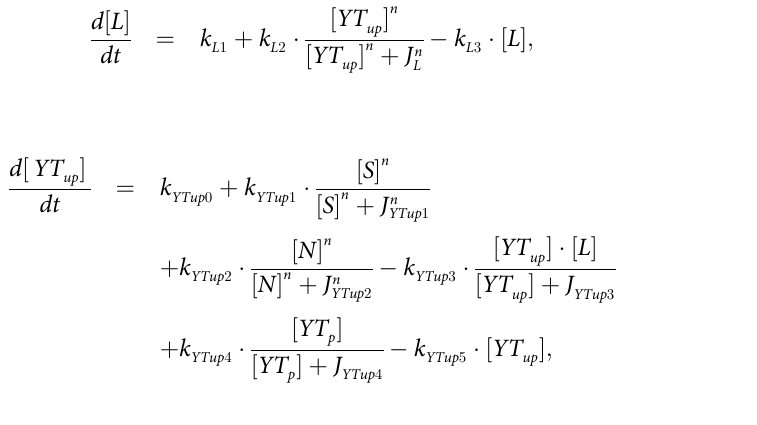
network in Fig 1. The Hippo signaling pathway regulates YAP/TAZ activity through phos- phorylation. Upon Hippo signaling activation, LATS1/2 is activated to phosphorylate YAP/ TAZ [1–6]. Dephosphorylation of YAP/TAZ is regulated by GPCR signaling [7]. In unpho- sphorylated form, YAP/TAZ stays in the nucleus and induces transcription of LATS2 [1], forming a negative feedback loop (Fig 1, red lines). The interactions between unphosphory- lated YAP/TAZ and SIRT1 form one positive feedback loop (Fig 1, blue lines), in which SIRT1 promotes the transcription of YAP, while YAP promotes transcription of SIRT1 [10, 12, 13]. YAP/TAZ and Notch form another positive feedback loop (Fig 1, green line), in which YAP/ TAZ activates Notch signaling by transcribing for Notch ligands and Notch promotes tran- scription of YAP [8, 9]. We used the following ordinary differential equations (ODEs) to describe the deterministic behavior of this regulatory network.